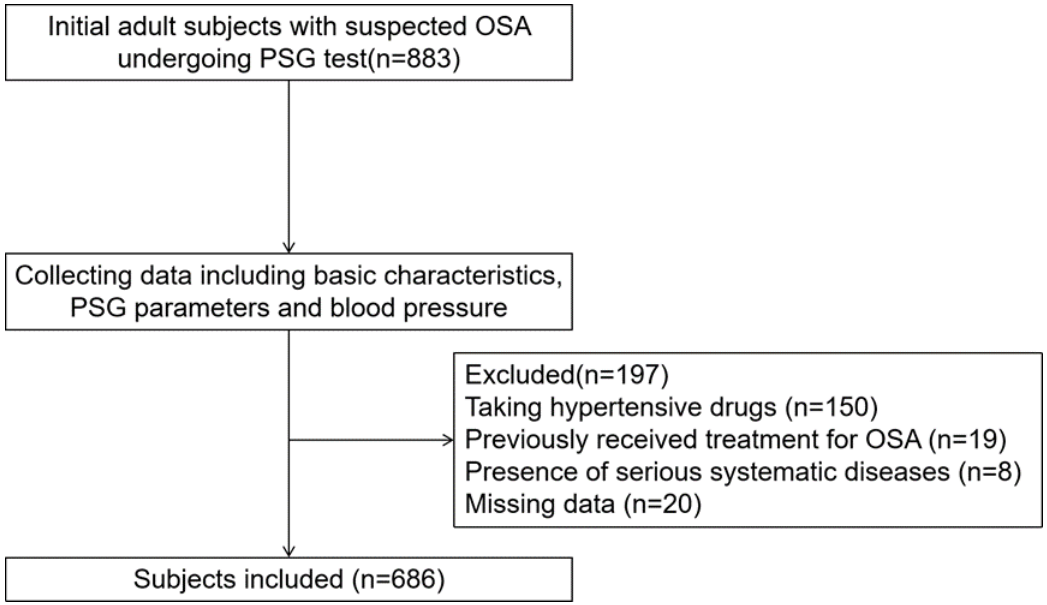
Figure 1. Enrollment flow chart of subjects. Abbreviations: OSA, obstructive sleep apnea; PSG, pol- ysomnography.